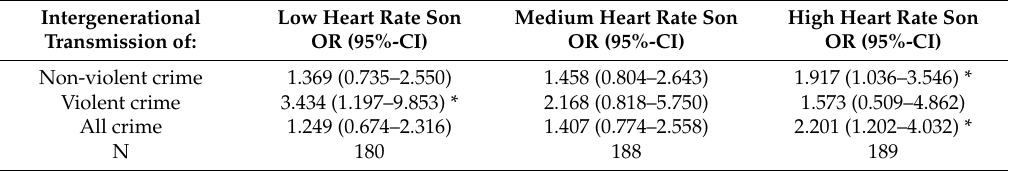
Table 5. Logistic regression analyses predicting offspring criminal behavior, separately for sons with low, medium and high heart